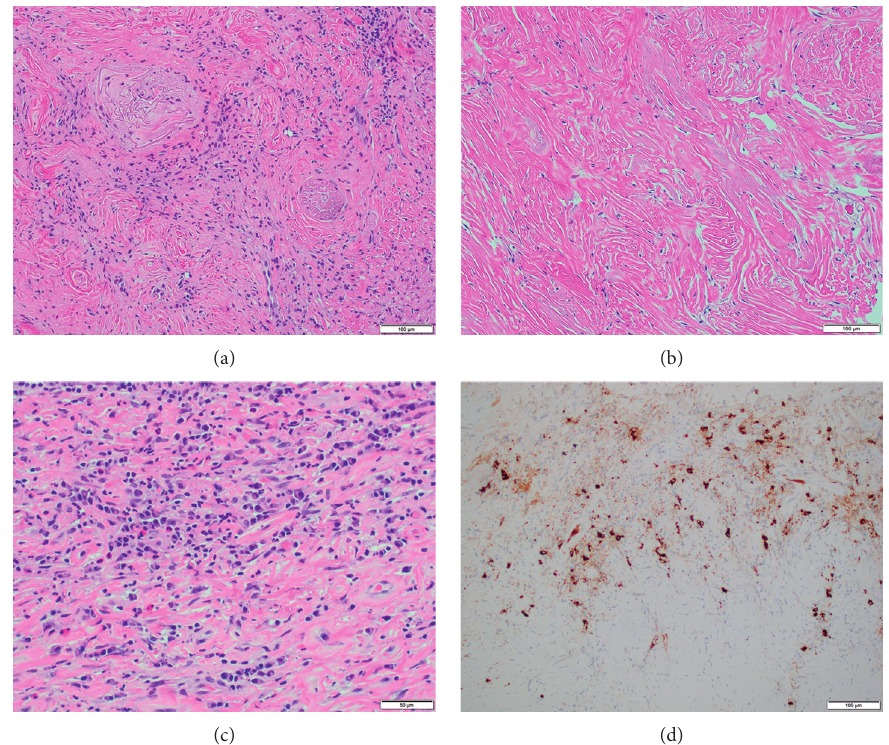
Figure 2: (a) Obliterative phlebitis—20x hematoxylin and eosin (H&E) stain showing cellular fibroinflammatory zone with irregular elastic remnants of larger vein; (b) storiform fibrosis—20x H&E stain showing paucicellular zone of whorled and interlacing collagen bundles with residual spindle-shaped fibroblast nuclei; (c) lymphoplasmacytic infiltration—40x H&E stain showing densely cellular inflammatory infiltrate with numerous plasma cells and eosinophils in a fibrous matrix; (d) immunohistochemistry shows strong positive brown chromogen decoration of IgG4-positive lymphoid cells, exceeding 50/high power